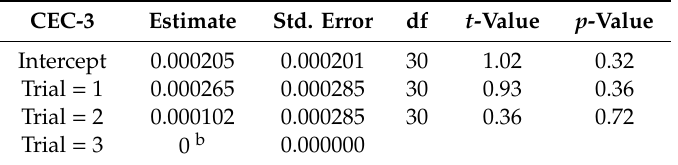
Table 7. Significant di ff erences among the mean of VR obtained per trial in CEC-3.